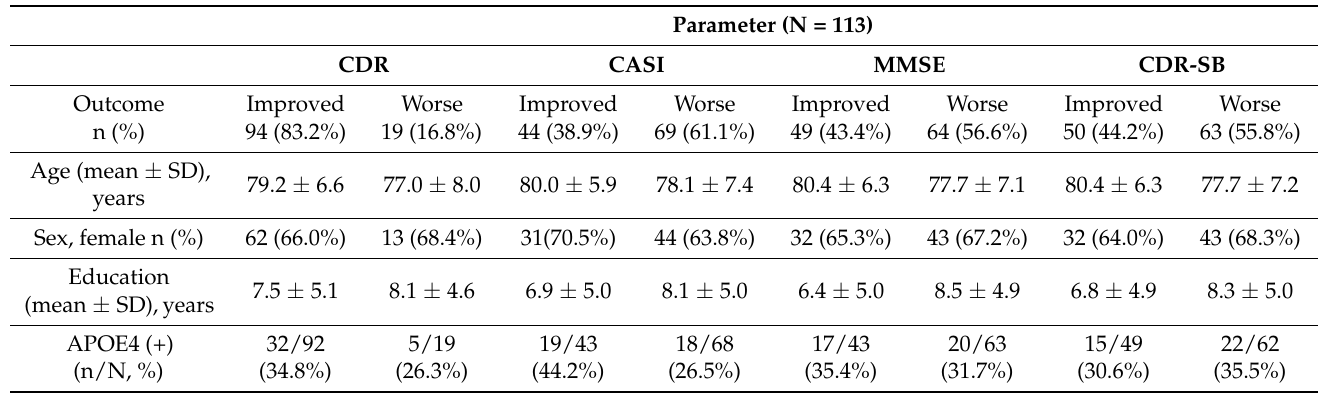
Table 2. Characteristics of clinical outcomes for patients with Alzheimer’s dementia as measured using different parameters.